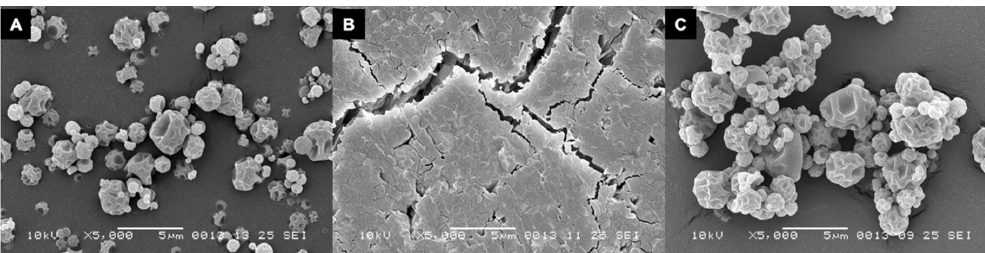
Figure 4. SEM images of the spray-dried amikacin formulation containing 1% L-leucine. Panel ( A ) shows the powder before DVS measurement. Panel ( B ) shows the same formulation after being exposed to 90% RH and panel ( C ) shows the same powder after being exposed to 40% RH during the DVS measurements. Magnification 5000× times.